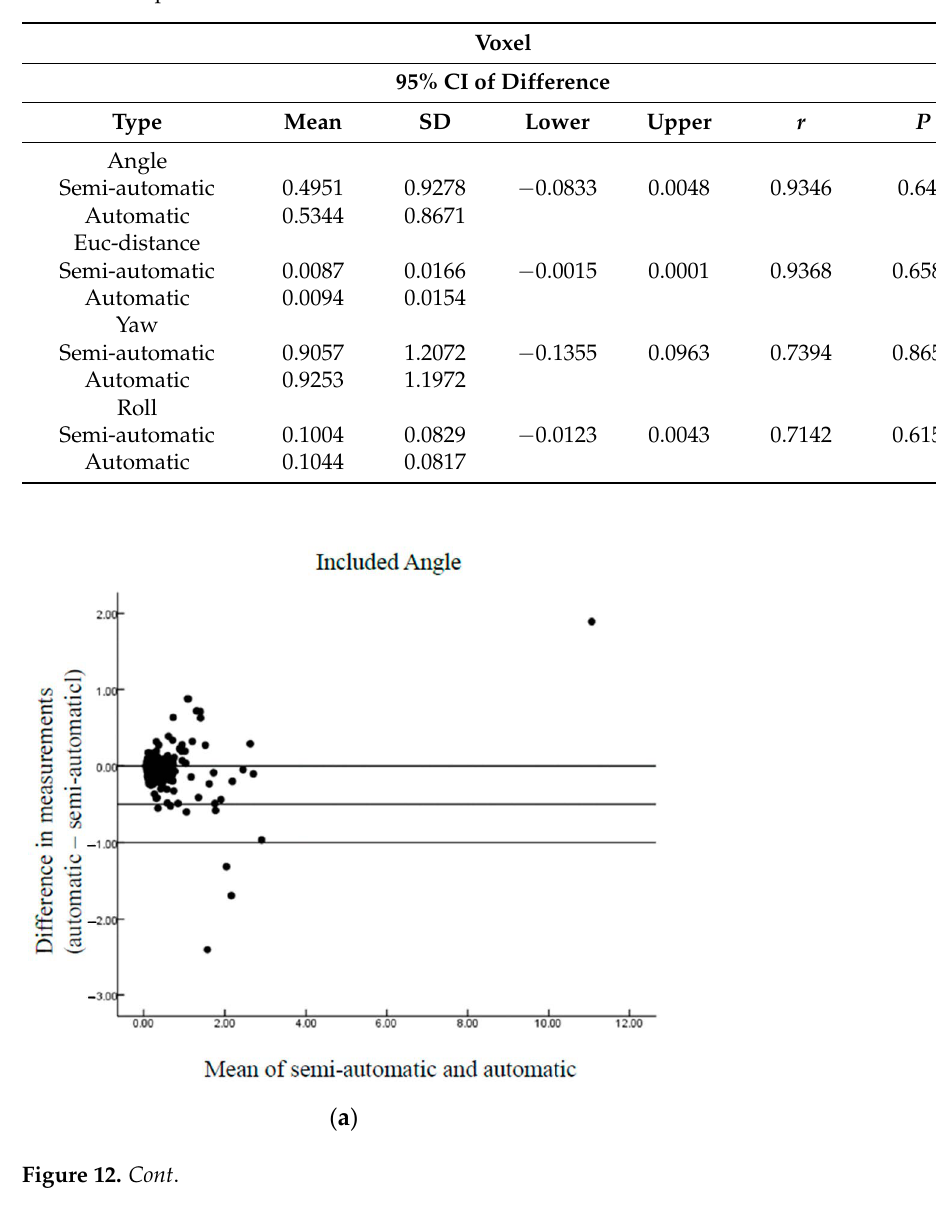
Table 1. Comparison of the automatic/semi-automatic and manual fetal MSP detection methods.